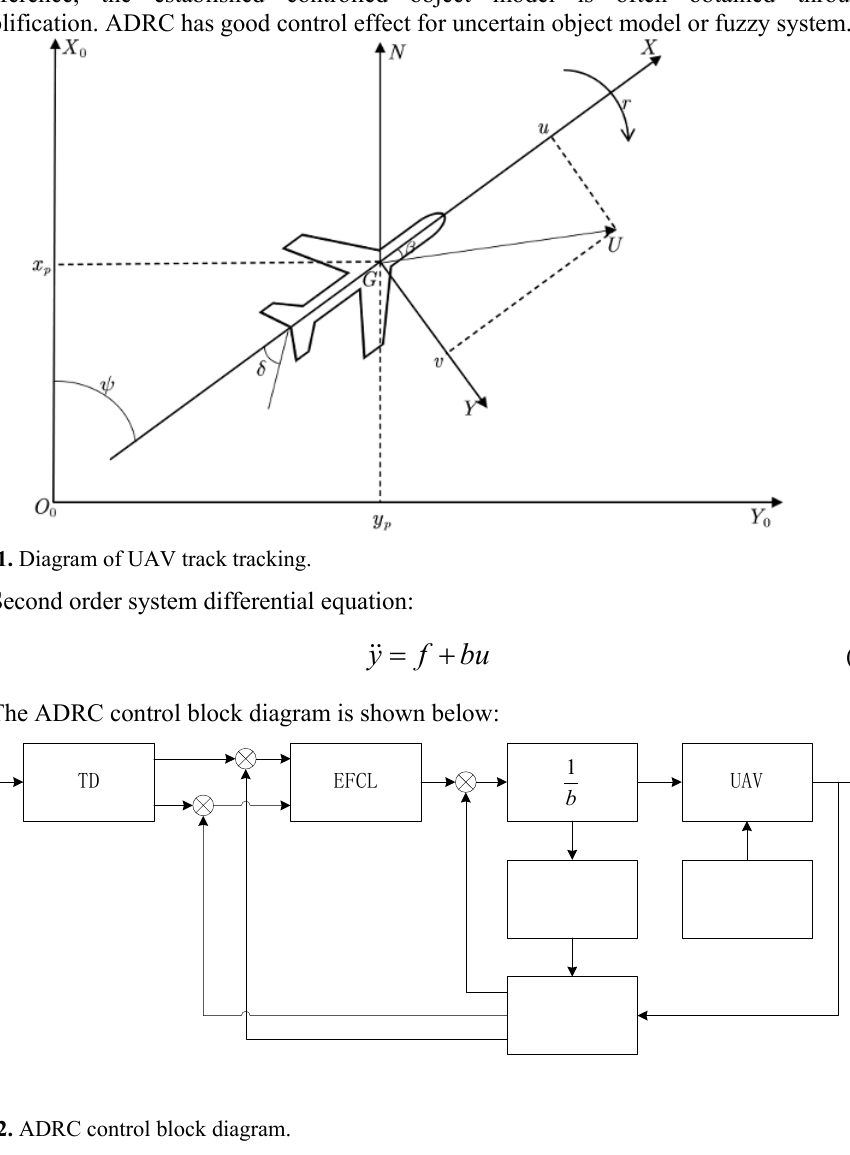
Fig. 2. ADRC control block